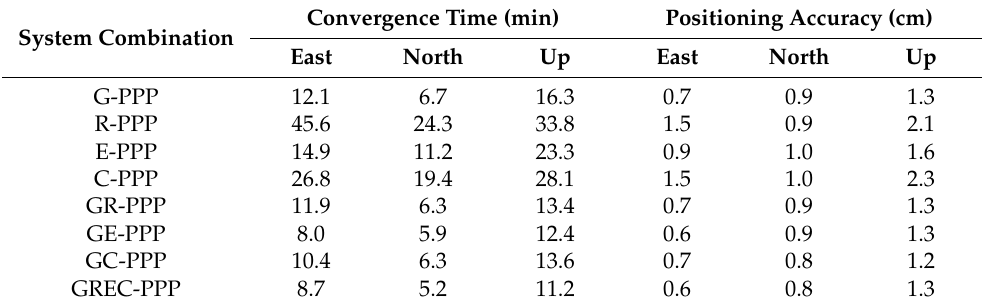
Table 12. Static positioning accuracy and convergence time of real-time PPP (long-term performance of PPP based on daily observations) with CNES products for different system combinations using the datasets from 29 stations spanning a